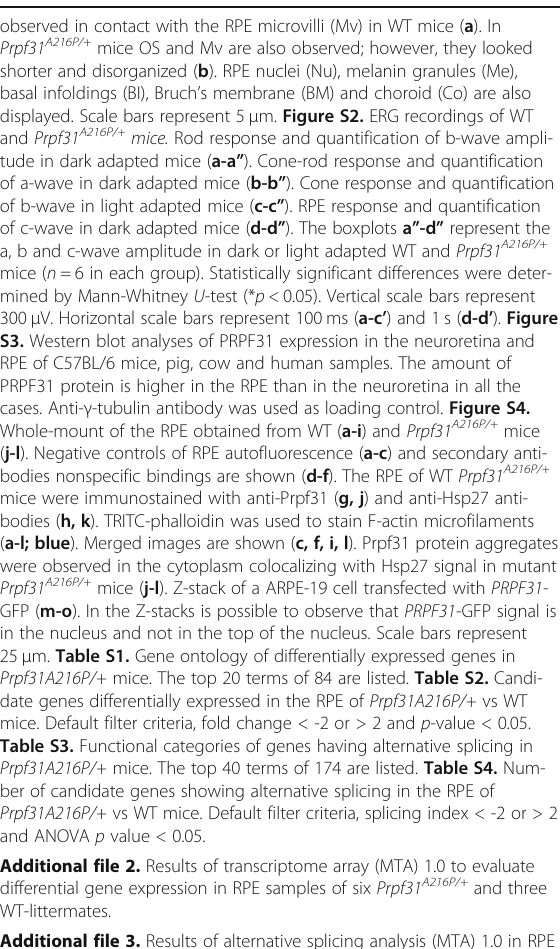
Table S3. Functional categories of genes having alternative splicing in Prpf31A216P/+ mice. The top 40 terms of 174 are listed. Table S4. Num- ber of candidate genes showing alternative splicing in the RPE of Prpf31A216P/+ vs WT mice. Default filter criteria, splicing index < -2 or > 2 and ANOVA p value <